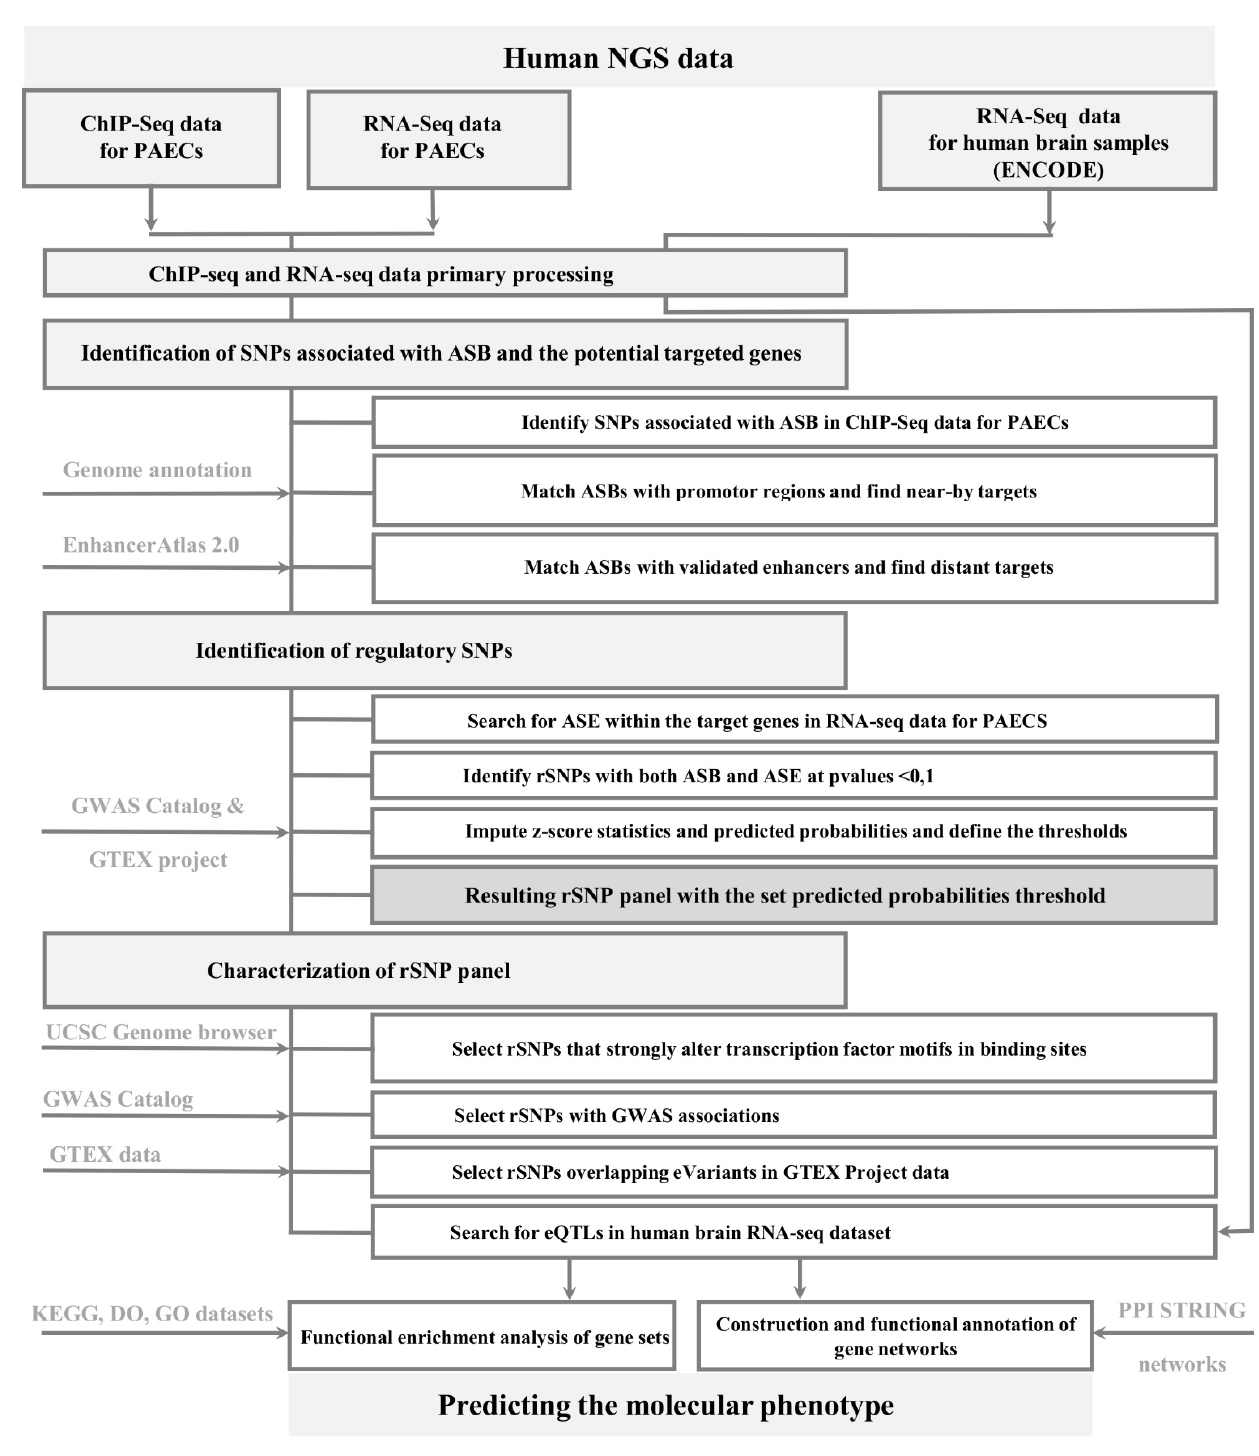
Figure 1. The stages of rSNP search assessing the likely molecular phenotypes and phenotypic outcomes.Arrows show the utilization of sequencing data or publicly available resources; NGS:next generation sequencing; PAECs:pulmonary arterial endothelial cells; SNP:single nucleotide polymorphism; rSNP:regulatory SNP; ASB:allele-specific binding bias; ASE:allele-specific expression bias; PPI;protein-protein interaction.